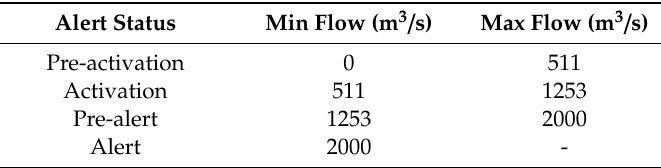
Table 5. Hazard thresholds for the Minho River at Ourense City.